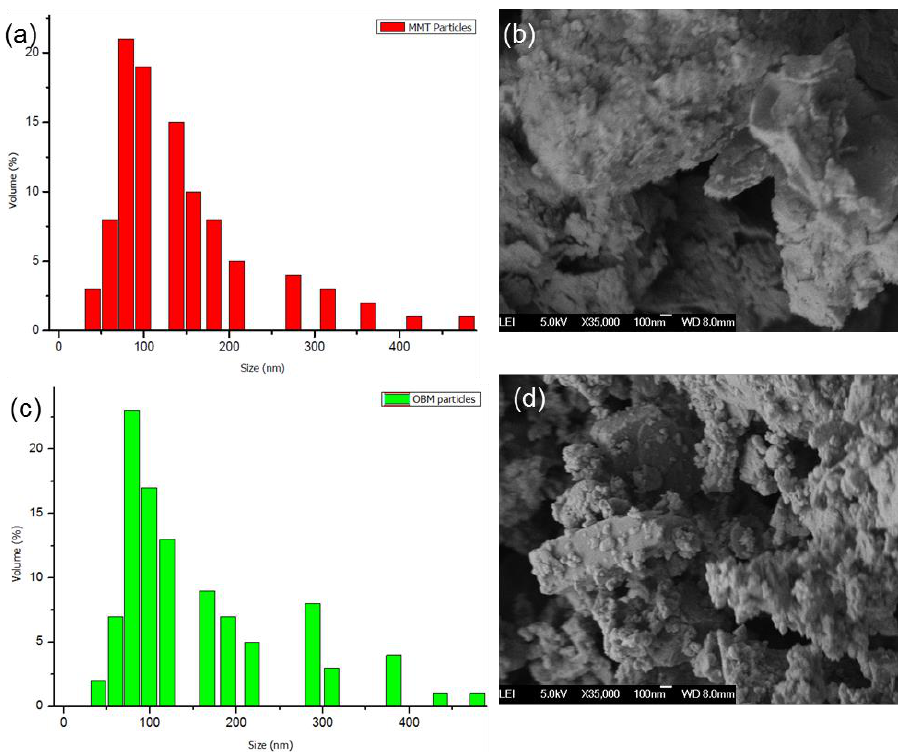
Figure 2. Particle size distribution ( a , c ) and SEM images ( b , d ) of the representative MMT and OBM clays.